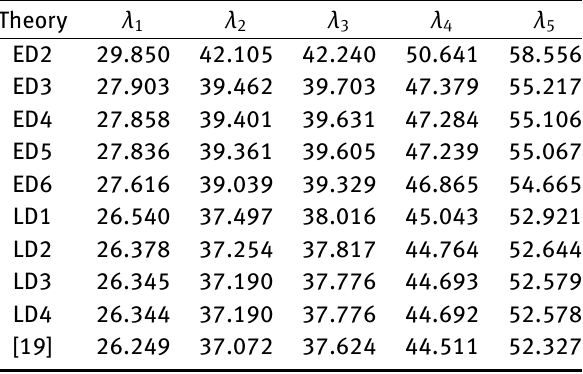
√︁ ρ Table 4: Non-dimensional frequency parameters λ = ω ( a 2 / h ) E 2